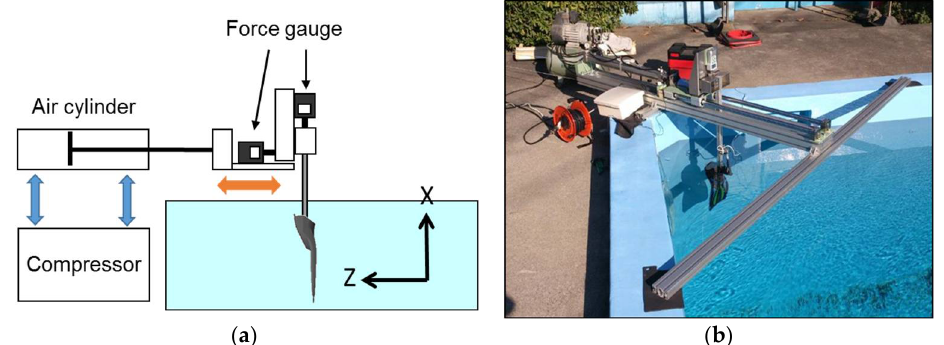
Figure 6. Experimental setup in order to determine the fluid force coefficients of the fin: ( a ) Schematic figure; ( b ) Photograph.